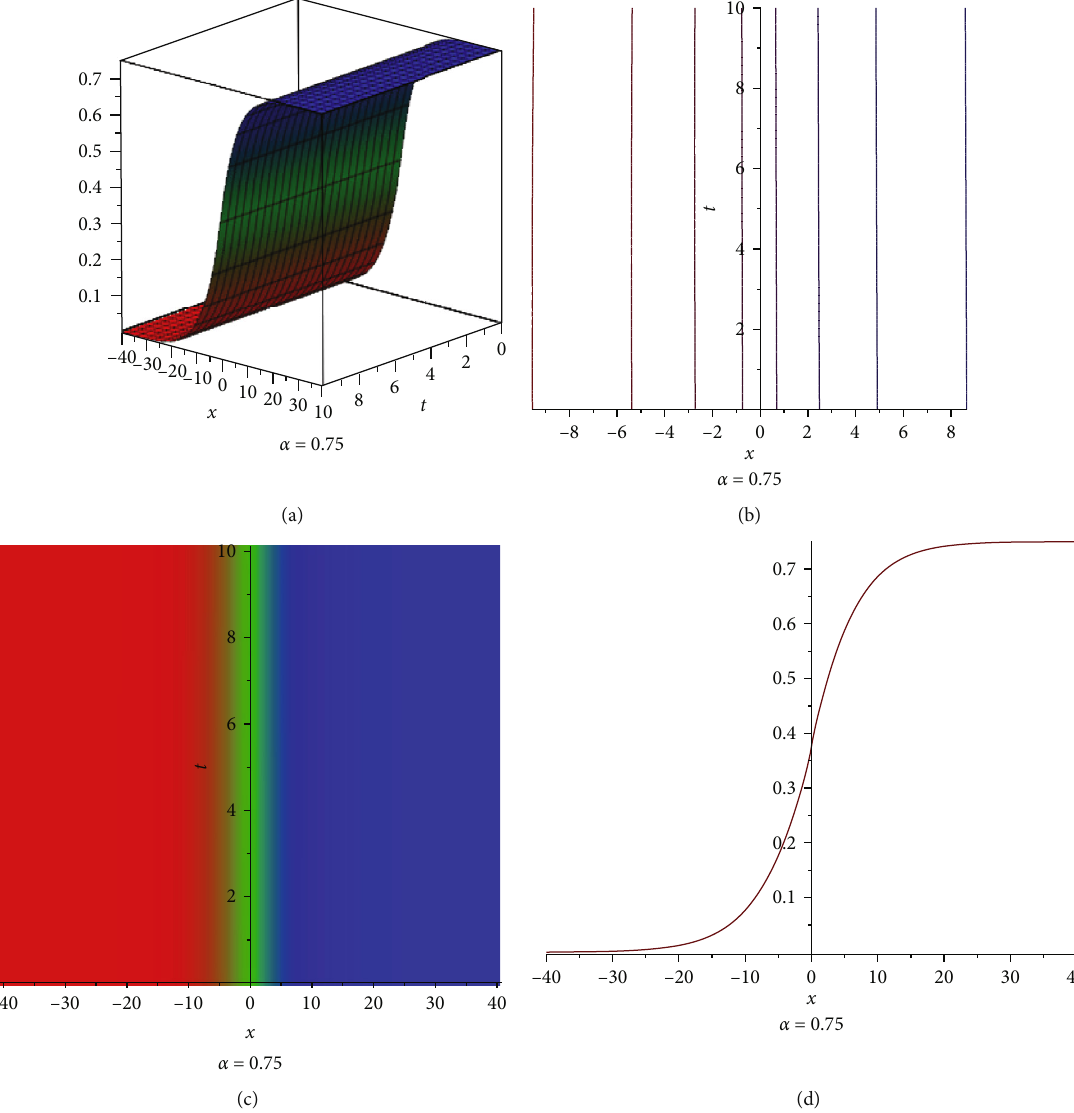
= 0 : 3, δ = δ = d = d = 0 : 1, 1 2 3 1 2